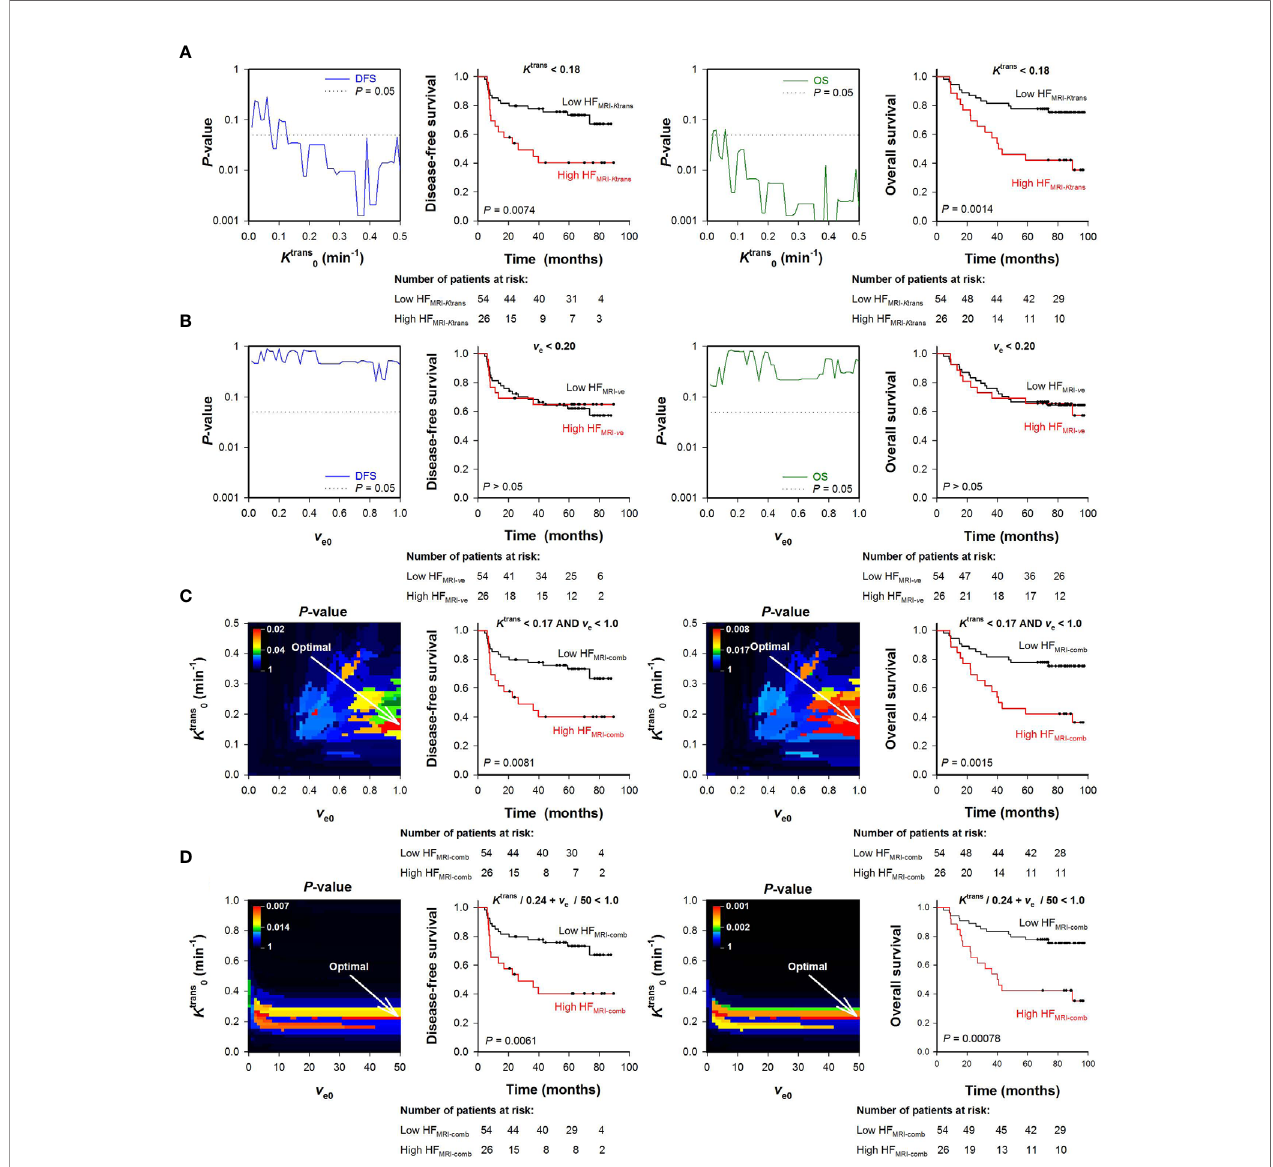
FIGURE 3 | Hypoxic fractions were calculated from K trans maps alone (HF MRI- K trans ), v e maps alone (HF MRI- v e ), or by combining K trans and v e maps (HF MRI-comb ) in locally-advanced cervical carcinoma patients. Voxels were de fi ned as hypoxic if K trans < K trans 0 (A) , v e < v e0 (B) , K trans < K trans 0 and v e < v e0 (C) , or K trans = K trans 0 + v e / v e0 < 1 (D) , where K trans 0 and v e0 were threshold values for K trans and v e respectively. A range of K trans 0 and v e0 values was investigated, and HF MRI was calculated for every patient and for every threshold. The outcome of patients with high HF MRI was compared with the outcome of patients with low HF MRI by using the log-rank test for every threshold. (A, B) Plots of P -values obtained by the log-rank test versus K trans 0 (A) or v e0 (B) , and examples of Kaplan-Meyer plots for patients with high and low HF MRI- K trans obtained by using K trans 0 = 0.18 min -1 (A) or patients with high and low HF MRI- v e obtained by using v e0 = 0.20 (B) . The P -value plots and the Kaplan- Meyer plots refer to disease-free survival (left side) and overall survival (right side). Dotted lines in P -value plots show P = 0.05. (C, D) Color-coded P -value images obtained by the log-rank test using combinations of K trans 0 and v e0 , and Kaplan-Meyer plots for patients with high and low HF MRI-conp obtained by using the optimal combinations of K trans 0 and v e0 (indicated by arrows in the P -value images). The P -value images and the Kaplan-Meyer plots refer to disease-free survival (left side) and overall survival (right side). The numbers of patients at risk refer to the time points indicated by the time-axis of the Kaplan-Meyer plots (i.e., 0, 20, 40, 60, and 80 months). The P -value scales are given by the color